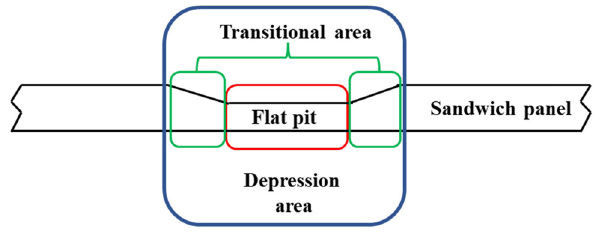
Figure 5: Depression area of protective